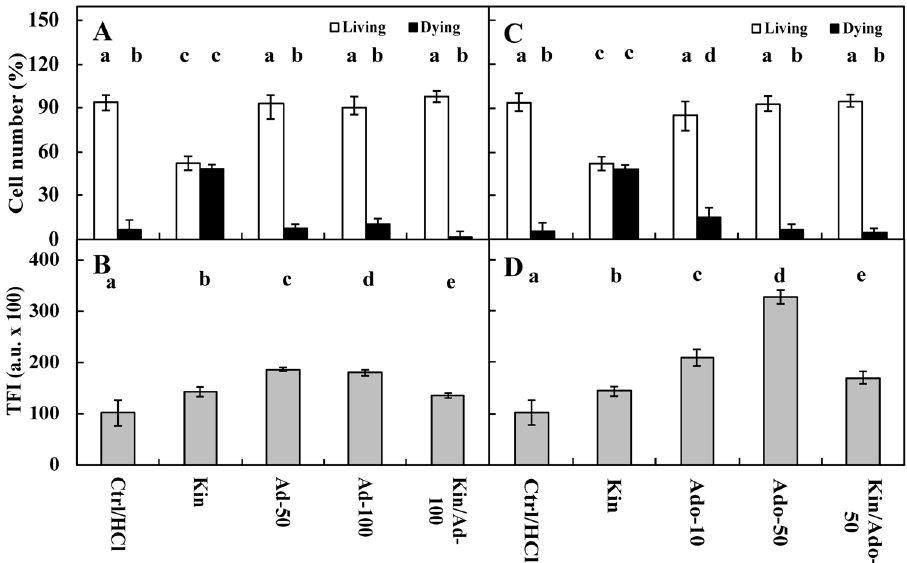
Figure 2. Number (%) of living and dying cells ( A ) as well as cytosolic calcium ion (Ca 2+ ) amounts ( B ) in Vicia faba ssp. minor cortex seedling apical roots after treatment with Ad (adenine), an inhibitor of phosphoribosiltransferase ( A , B ), and Ado (5 ′ -amine-5 ′ -deoxyadenosine), an inhibitor of adenosine kinase activity ( C , D ). The number of living and dying cells as well as the amounts of Ca 2+ were fluorescently estimated after staining with acridine orange, ethidium bromide and chlortetracycline. Bars indicate ± SE of the results from three biological replicates. The means of the results with the same letter above the column are not significantly different at p ≤ 0.05. Ad–50, 50 μM Ad; Ad–100, 100 μM Ad; Ado–10, 10 μM Ado; Ado–50, 50 μM Ado; Ctrl, control; Kin, kinetin; Kin/Ad–100, kinetin with 100 μM Ad; Kin/Ado–50, kinetin with 50 μM Ado; TFI, total (integrated) fluorescence